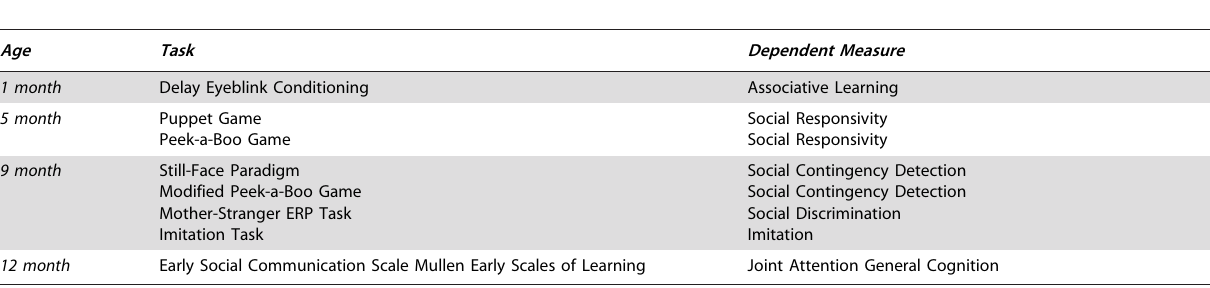
Table 1. Tasks and measures collected at different ages during